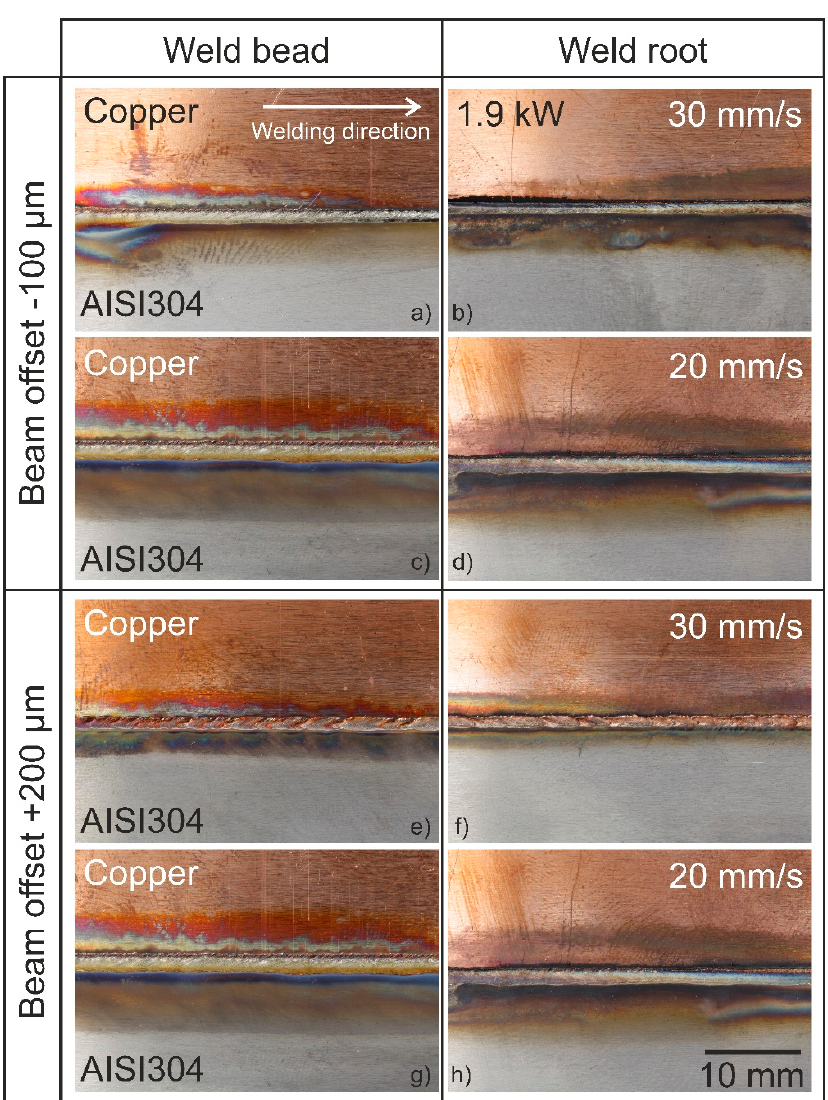
Figure 3. Weld bead and root appearance for welded joints produced with laser power of 1.9 kW. a